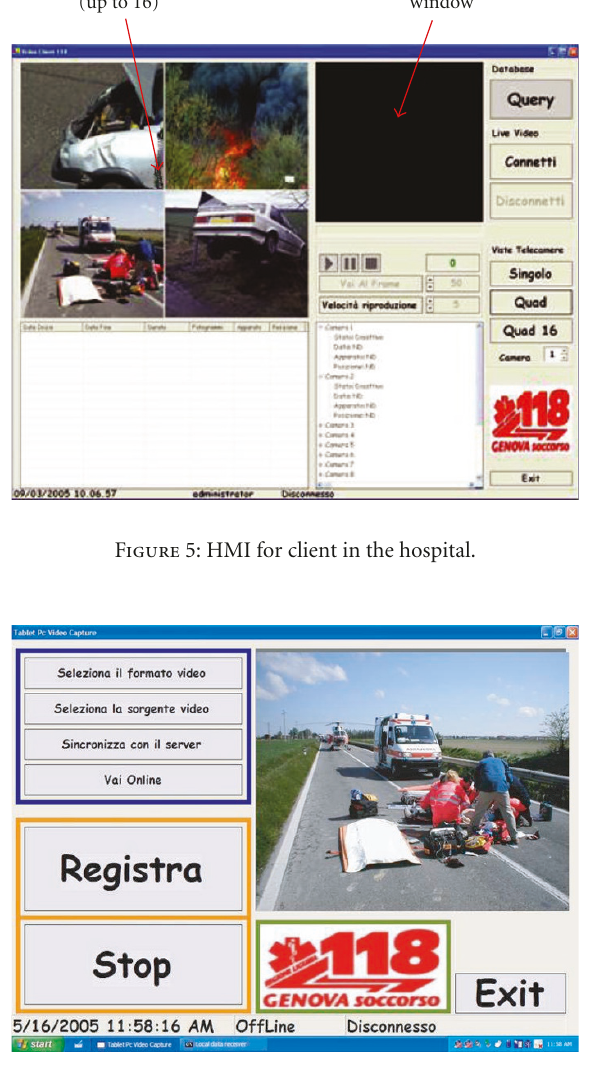
Figure 6: HMI of the mobile client.